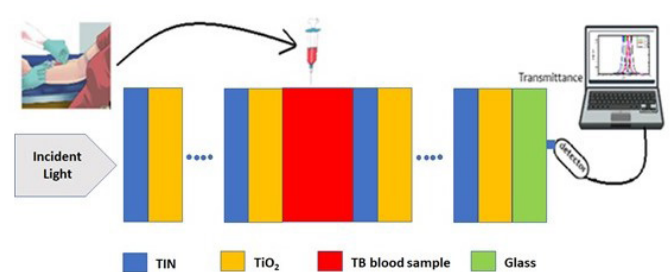
Figure 1. Schematic representation of the bio-photonic sensor structure.